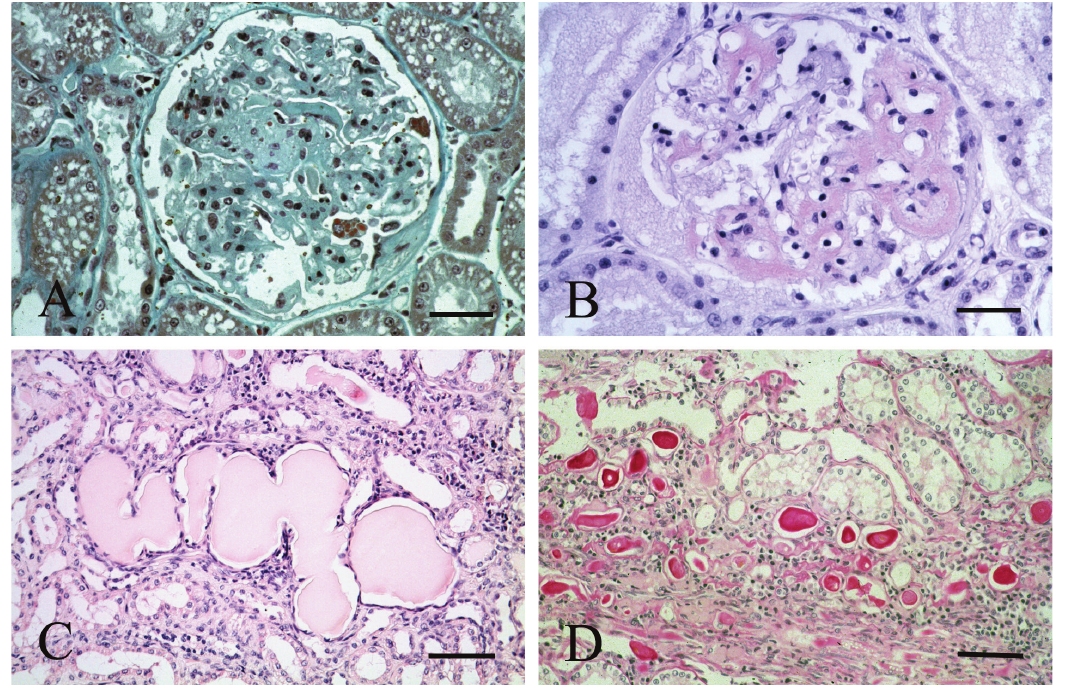
Figure 3. Representative results of renal lesions observed in naturally FIV-infected cats. ( A ) Mesangial widening with segmental glomerulosclerosis. Increase in mesangial matrix with a minimal increase in intraglomerular cellularity. Protein droplets were detectable within podocyte cytoplasmas. Azan trichrome stain. (Bar = 80 µm); ( B ) Glomerular amyloidosis. Diffuse increase of capillary walls due to amyloidosis depostion. Congo red stain. (Bar = 80 µm); ( C ) Tubular mycrocysts. Presence of interstitial infiltration and dilated tubules forming tubular mycrocysts. Hematoxylin-Eosin stain. (Bar = 80 µm); ( D ) Giant protein cats. PAS-positive proteinacous cats within tubular microcysts. PAS stain. (Bar = 80 µm).